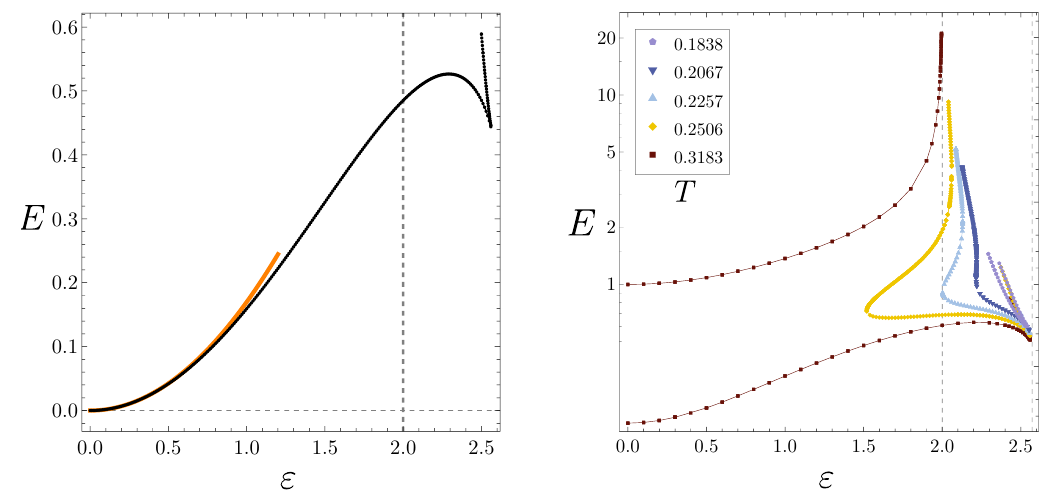
Figure 10 . Left : soliton solution boundary energy against rotation parameter. The dashed vertical gridline marks the critical amplitude " = 2, and the bold orange line is the perturbative result. Right : log-linear plot of the energy for the black hole solutions against " , for several values of T